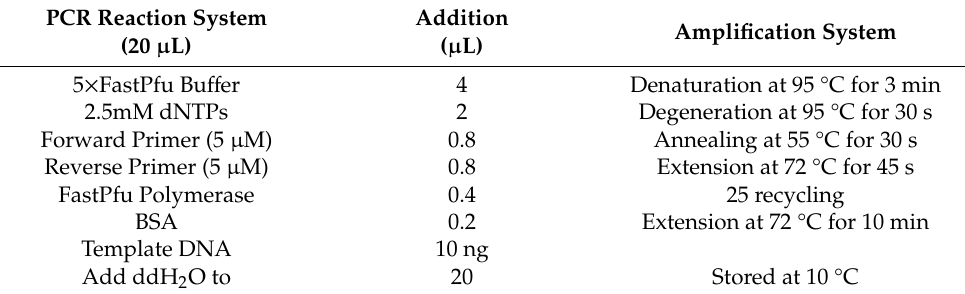
Table 3. PCR reaction system and amplification program of